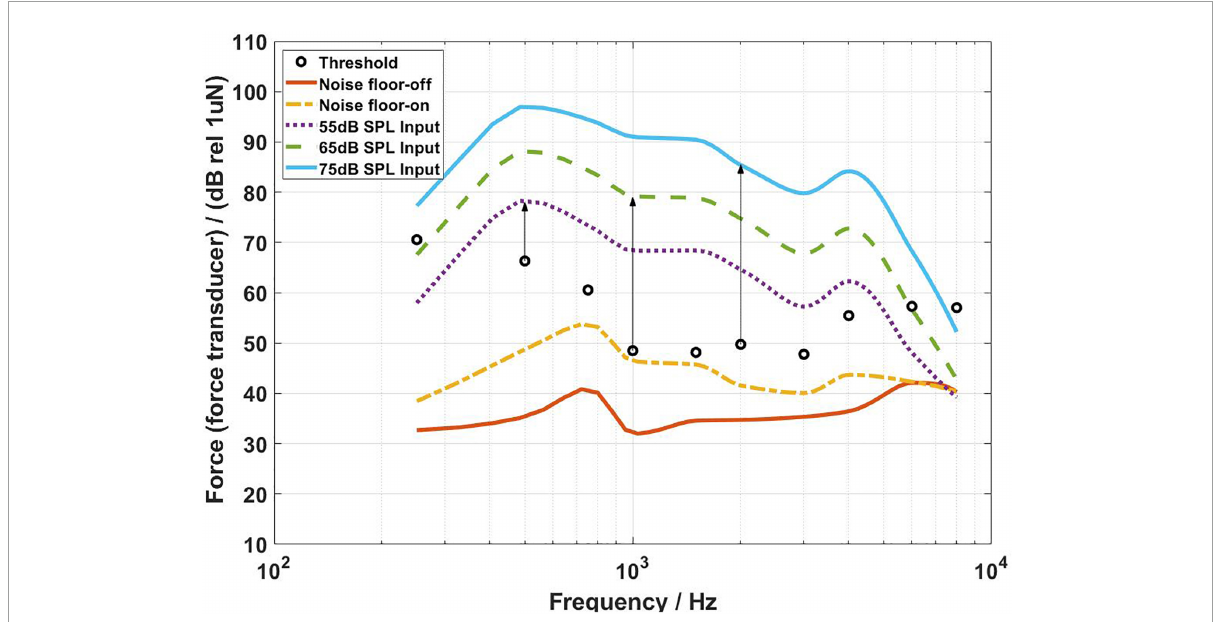
FIGURE4 The FL_FT corresponding to the bone conduction (BC) hearing threshold (referenced to the B81 transducer stimulation position) and the aided responses at 55, 65, and 75 dB SPL input levels. The arrows depict the audibility calculations.